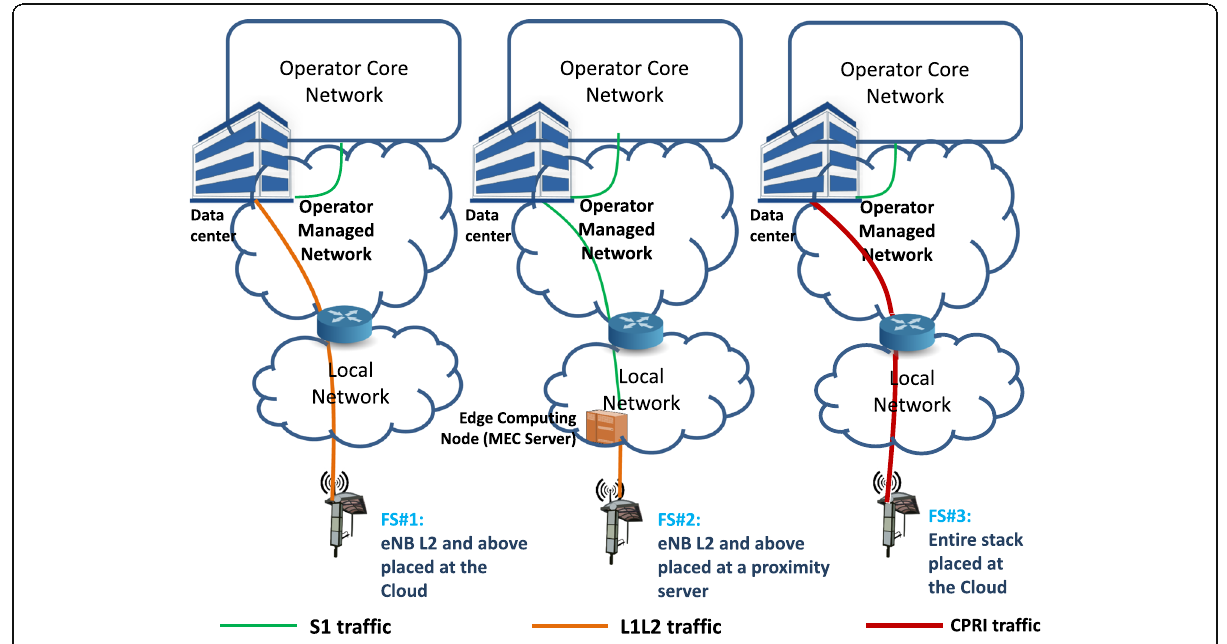
Fig. 3 Some indicative FSs with their respective traffic